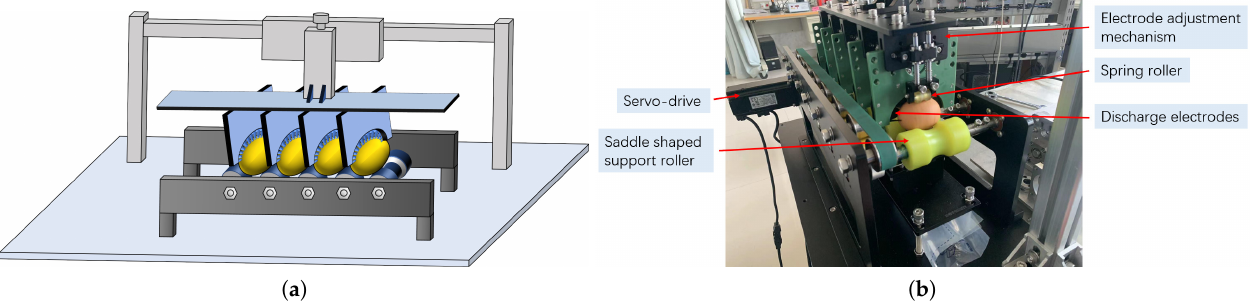
Figure 7. Egg crack detection device. ( a ) Model diagram. ( b ) Physical